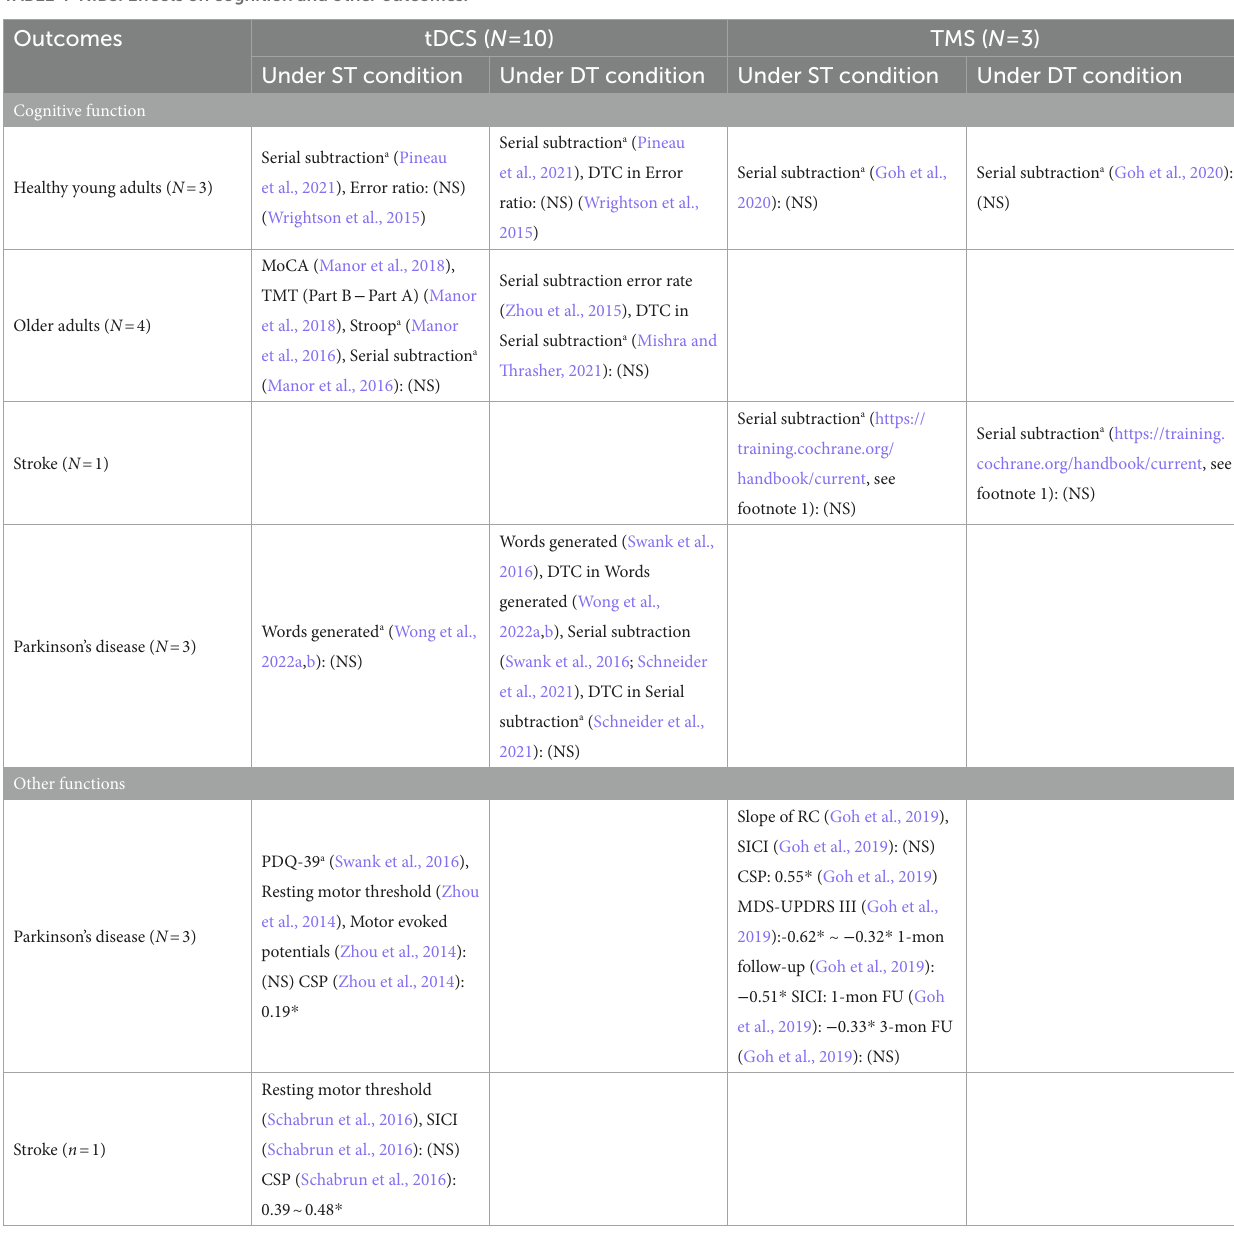
TABLE 4 NIBS: Effects on cognition and other outcomes.